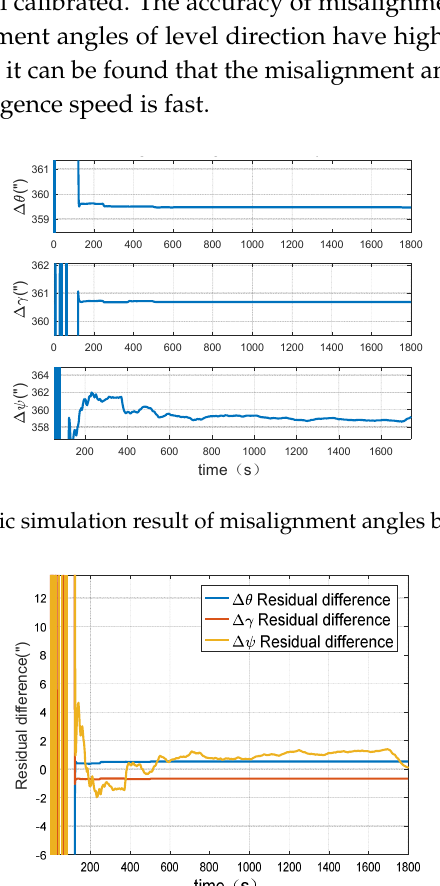
Figure 10. Residual difference between estimate value and setting value of misalignment angles between two inertial navigation systems (INSs).